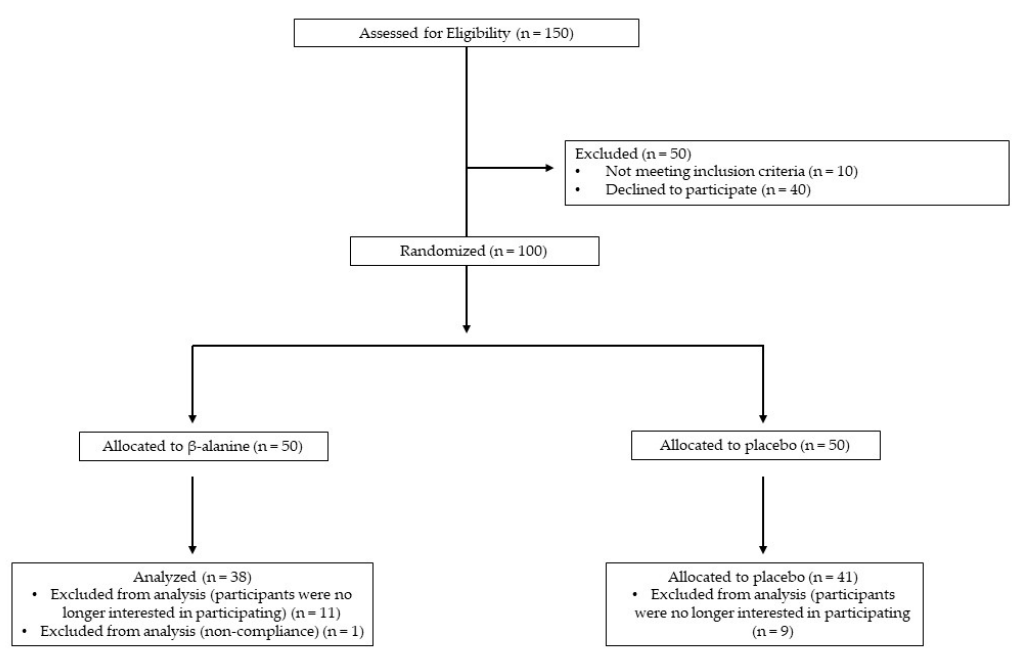
Figure 1. Study Flow Chart of Recruitment and Participant Analysis.